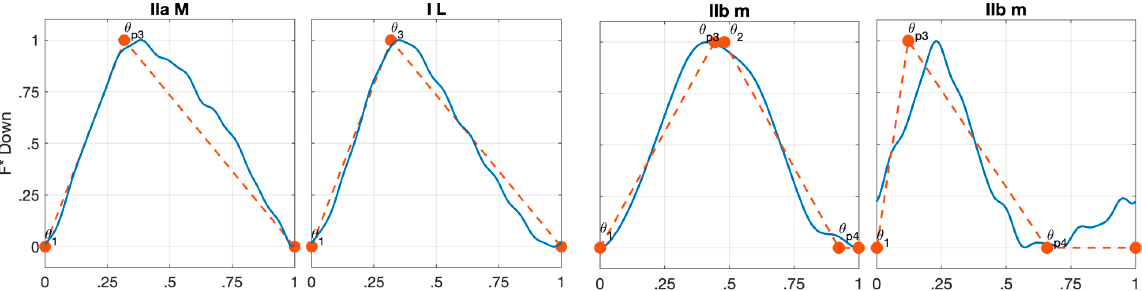
Figure 12. Normalized total forces comparison: test 15 vs. 33; test 22 vs.